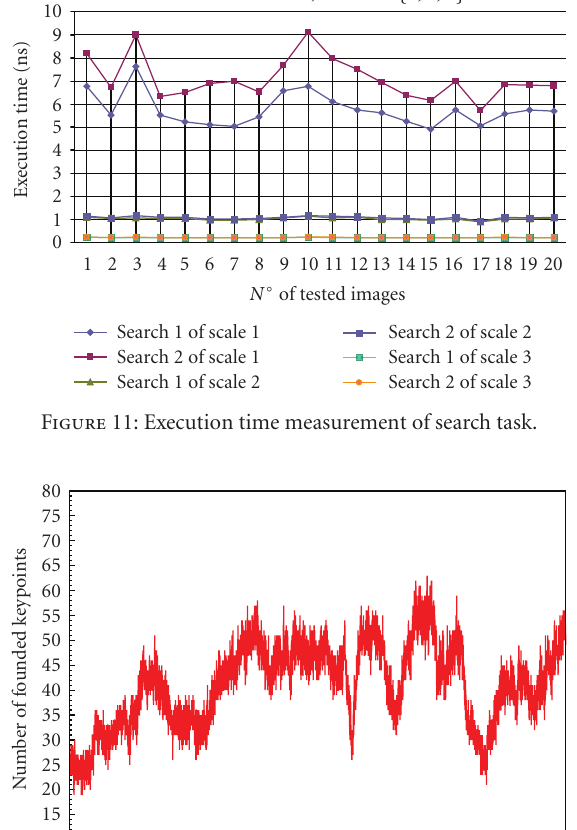
a sequence of more than 5000 images. It corresponds to the search task T 18 of scale 1, and it has almost the same look as other search tasks { T 20, T 9, T 11, T 27, T 29 } of di ff erent